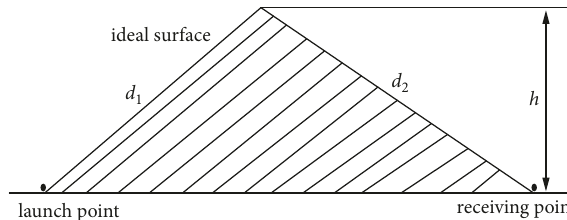
Figure 4: Schematic diagram of the single-edge peak diffraction